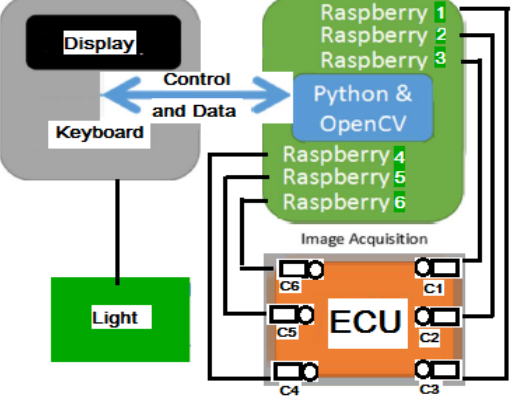
Figure 20. Schematic view of the IP-LC-FD prototype.